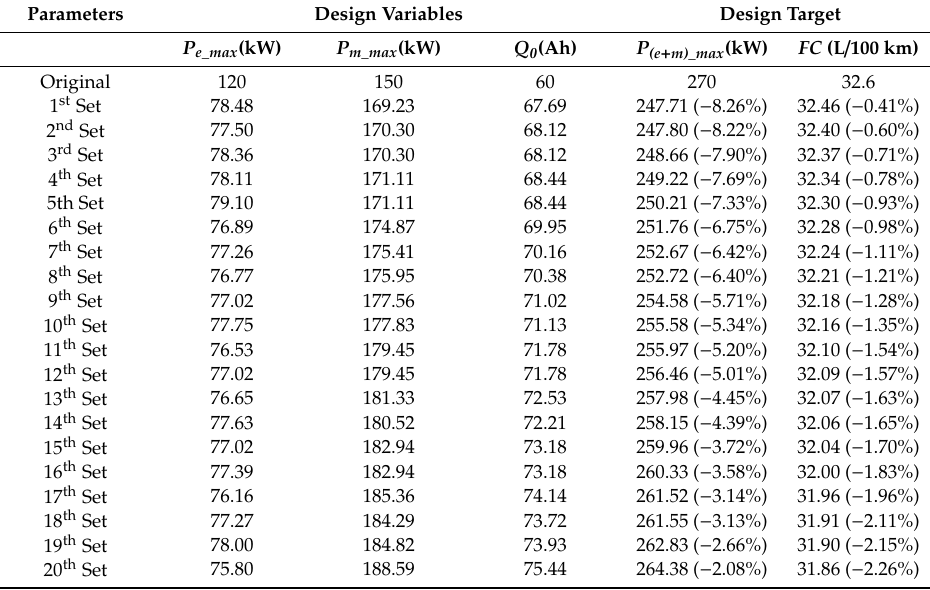
Table 5. Optimal matching results using NSGA-II algorithm.